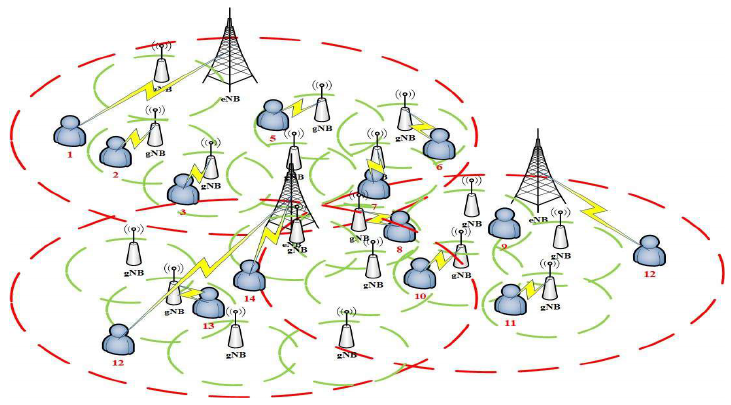
Figure 1. The network